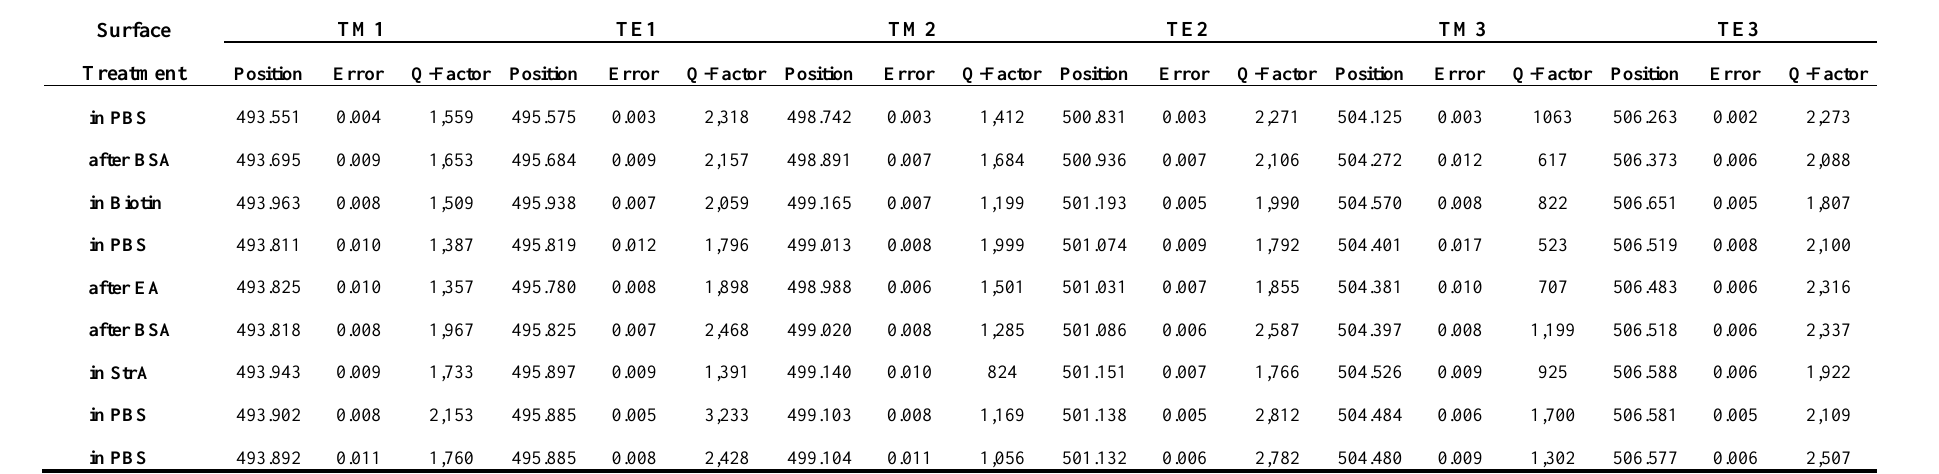
Table 1. WGM peak positions (in nm), their errors as resultant from the fitting routine (in nm), and the respective WGM quality factors for the WGM spectra of the different surface treatment steps of the biomolecular adsorption experiment as used for the quantitative evaluation shown in Figure 4. The modes are labeled according to their polarization (TM or TE) and numbered beginning with the modes with shortest